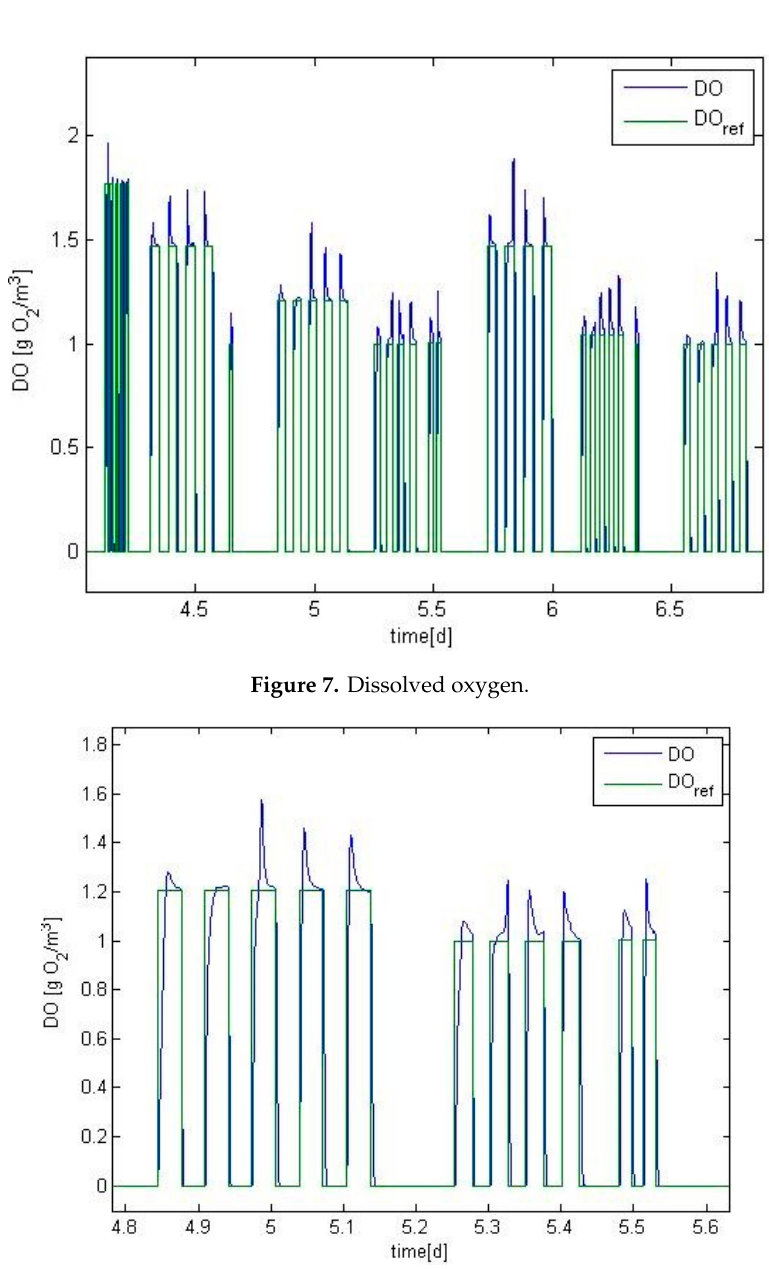
Figure 8. Dissolved oxygen—zoom.